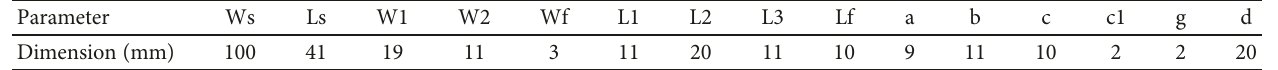
Table 1: Dimensions of the parameters of the MIMO antenna system.